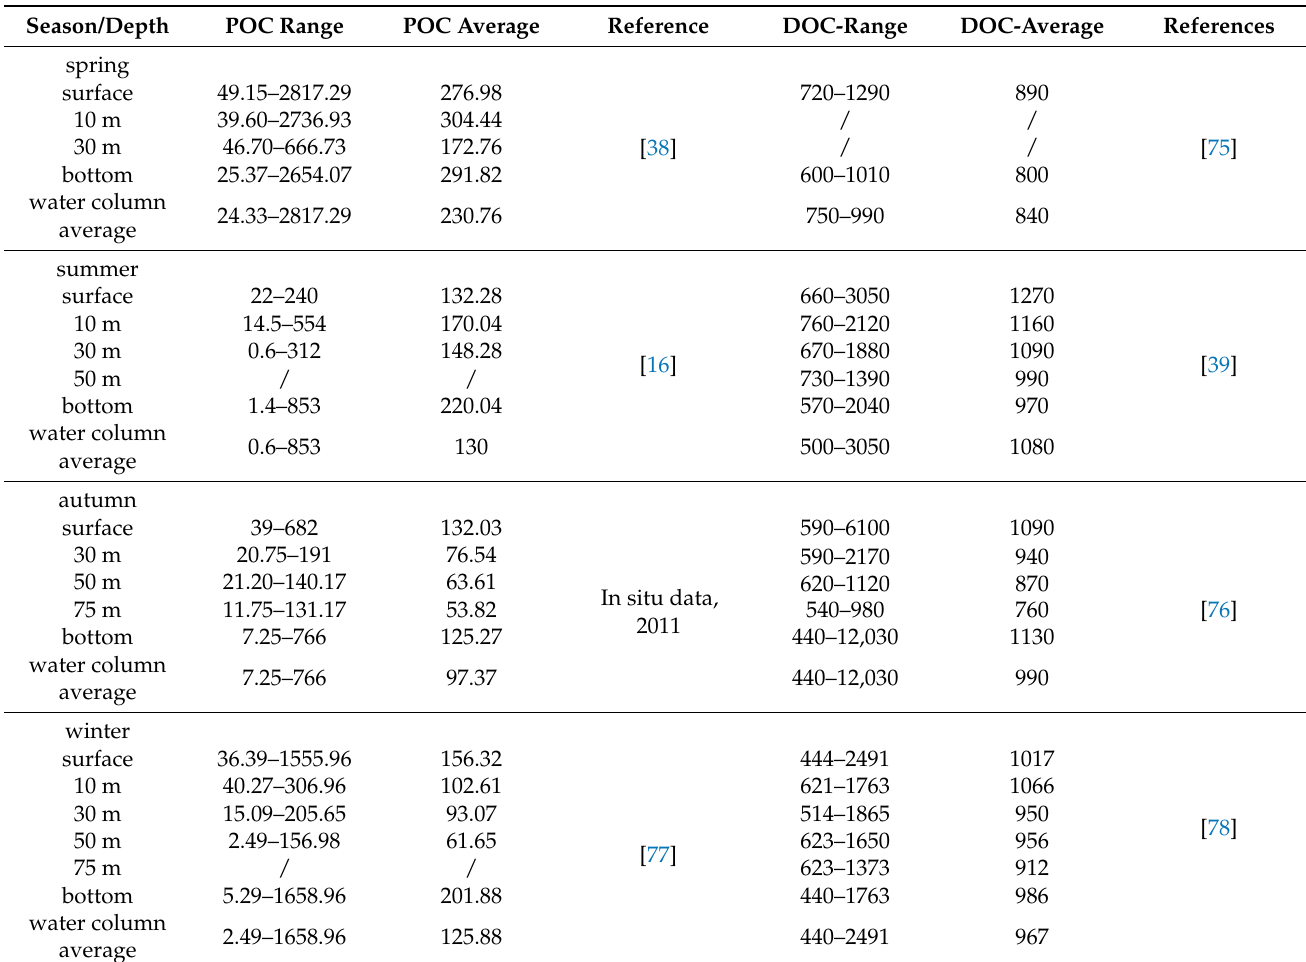
Table 2. Seasonal measured POC and DOC data collected from different cruises in ECS (Unit: mg m − 3